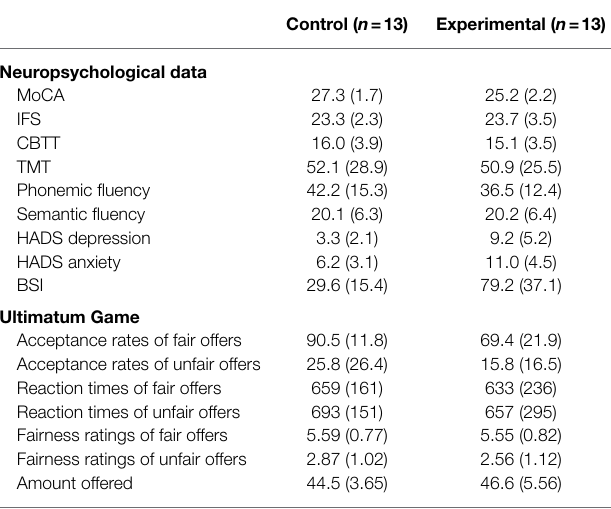
TABLE 2 | Mean (and SD) values of sociodemographic data, neuropsychological tests, and UG task of the